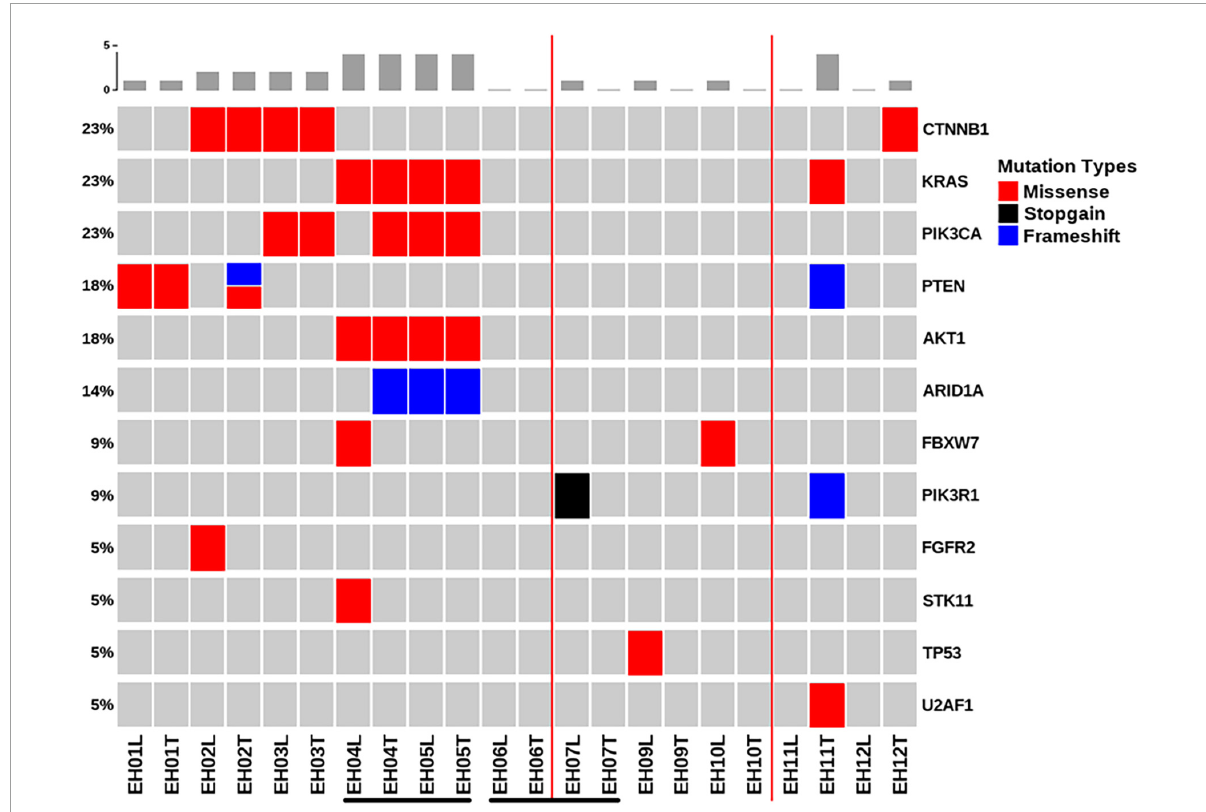
FIGURE1 Distributions of gene mutations identified in endometrial lavage samples and tissue specimens obtained from women with atypical endometrial hyperplasia. Samples EH04 and EH05 were obtained from the same patient, as were samples EH06 and EH07. They are underlined with black lines. Red lines indicate the concordance category (mutations identified in endometrial lavage samples and tissue specimens; mutations in endometrial lavage samples only, and mutations in tissue specimens only). T, tissue specimen; L, endometrial lavage sample.